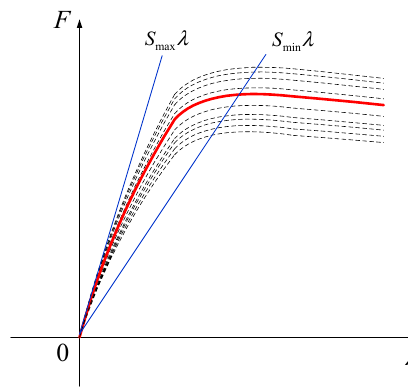
Figure 11. Vehicle control system as a multi-agent-system with perturbation.